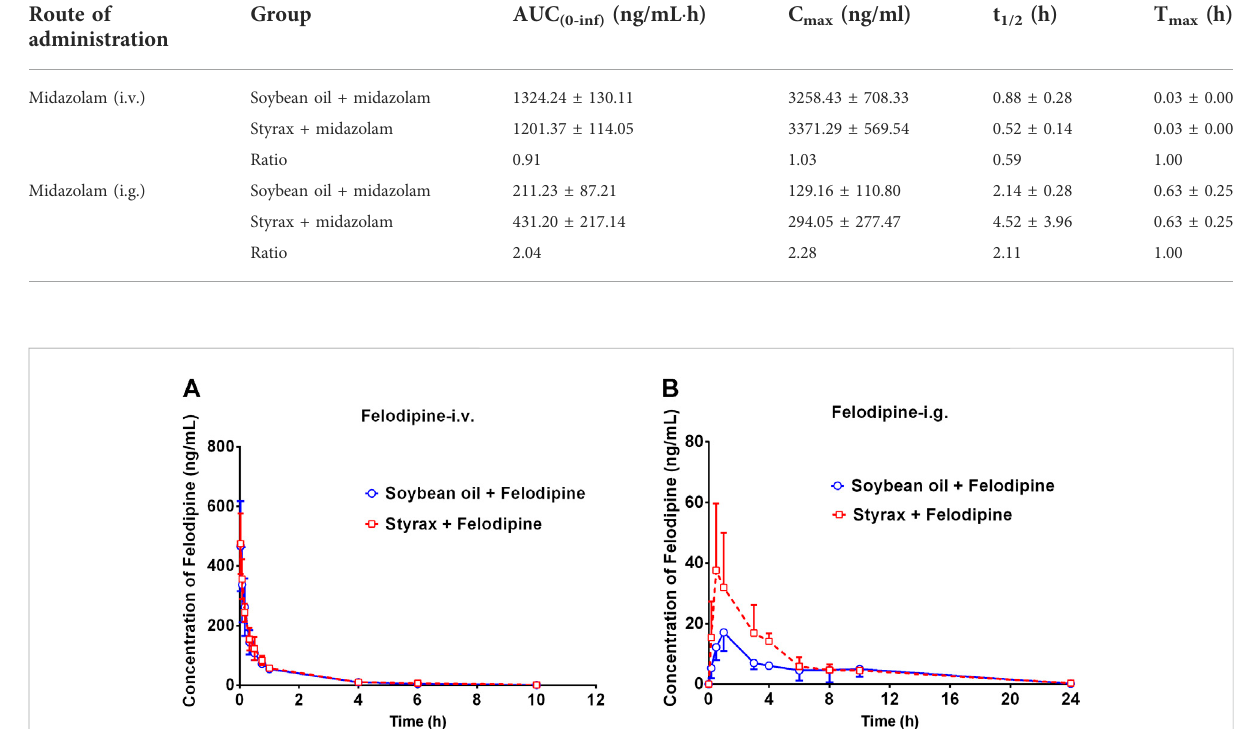
FIGURE 4 (A) The mean plasma concentration-time curves of felodipine after intravenous administration of felodipine (2 mg/kg) in rats pretreated with Soybean oil (blue) or Styrax (i.g. 100 mg/kg, red). (B) The mean plasma concentration-time curves of felodipine after intragastric administration of felodipine (10 mg/kg) in rats pretreated with (blue) or Styrax (i.g. 100 mg/kg, red). Data are expressed as the mean ± SD.